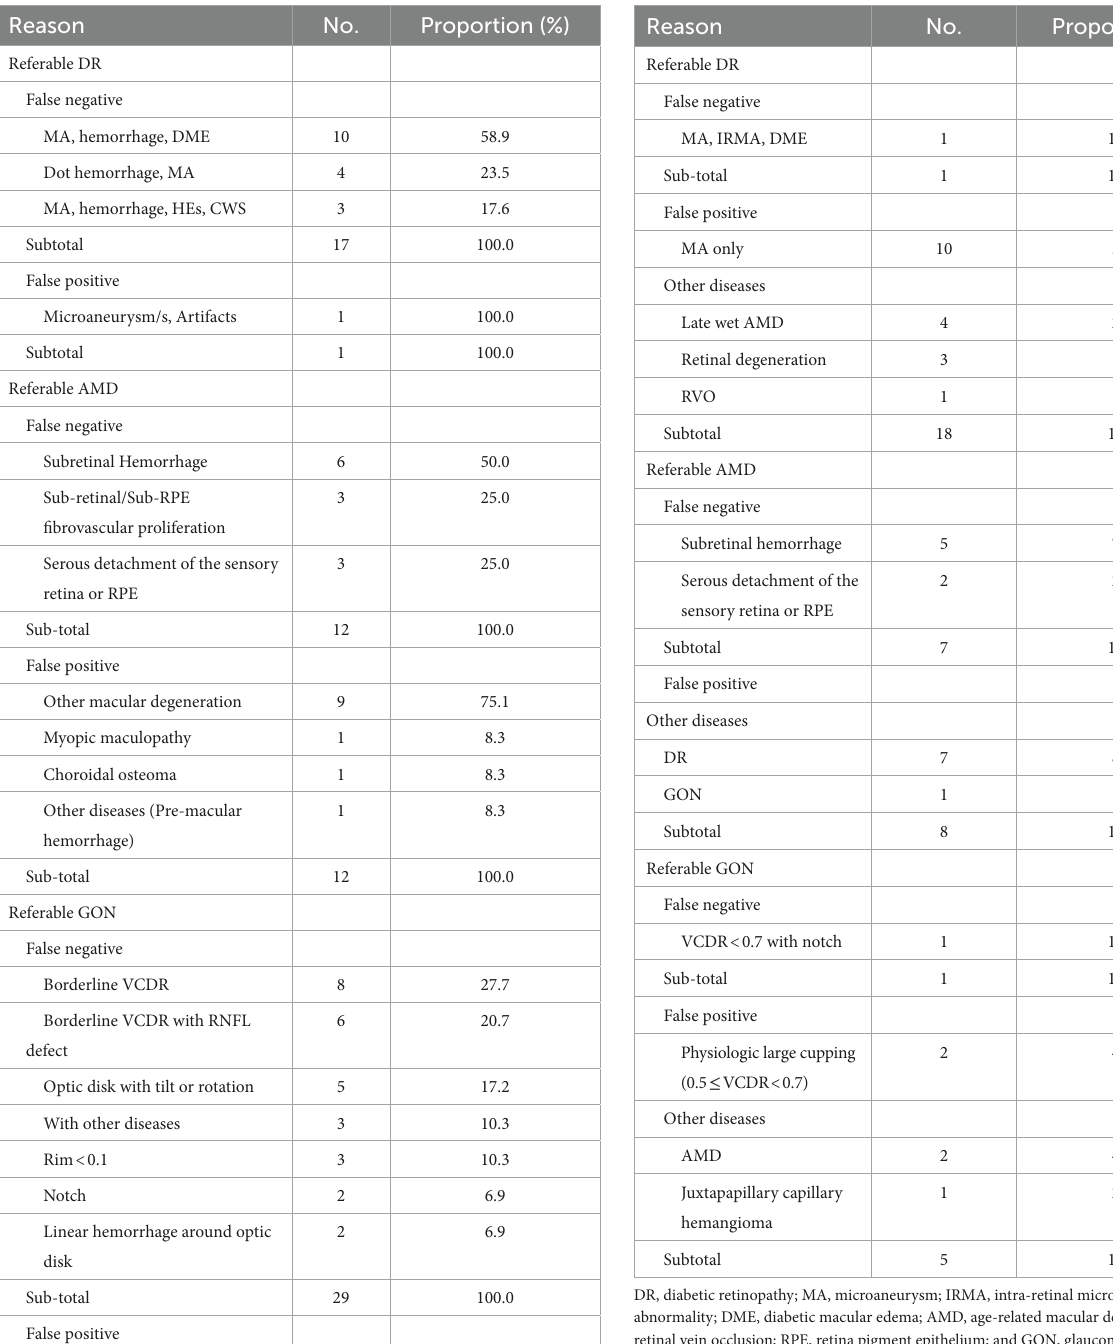
TABLE 6 Characteristics of the disagreement images by deep learning